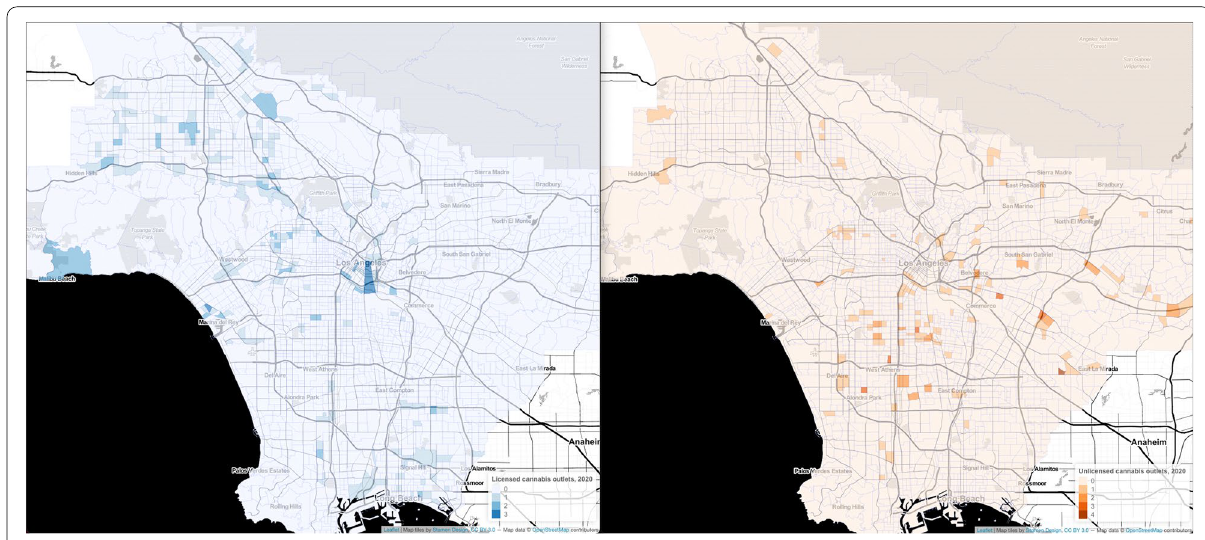
Fig. 1 Licensed and unlicensed cannabis outlets in Los Angeles County census tracts,